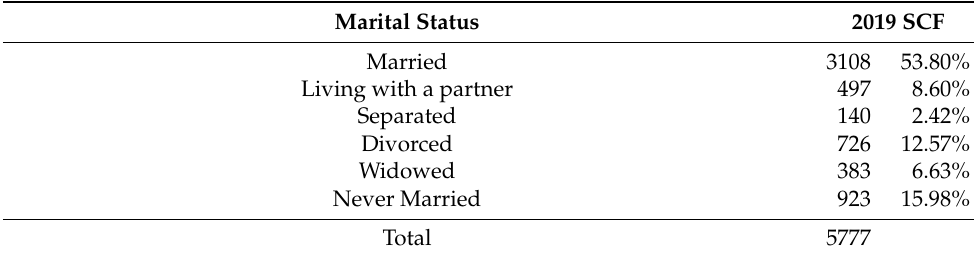
Table 3. Sample Frequencies of Households by Marital Status in the 2019